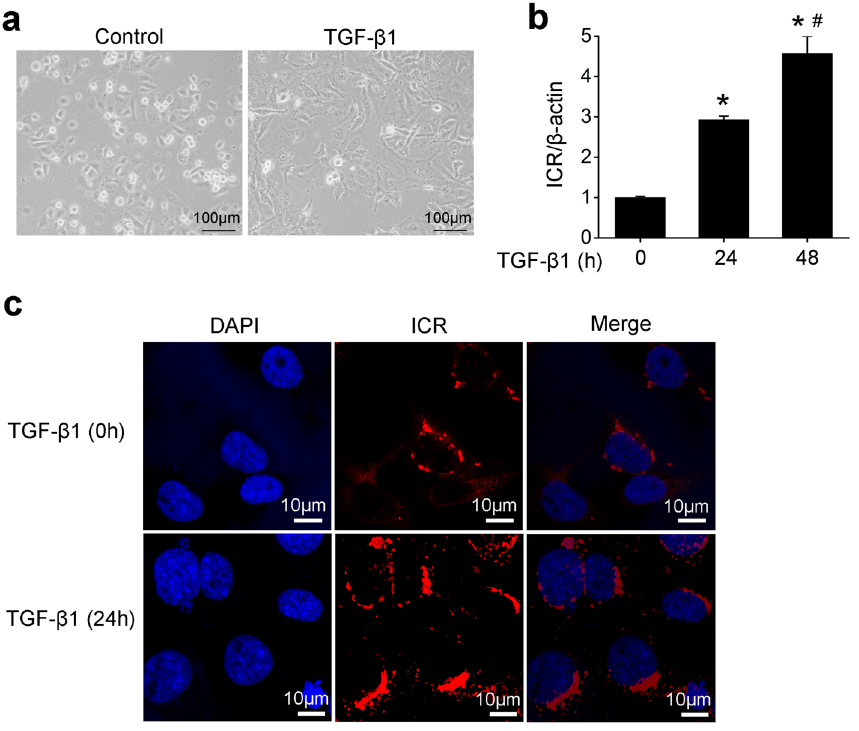
Figure 3. ICR was upregulated in human proximal tubular HK-2 cells cultured with TGF-β1. ( a ) The cell morphology of HK-2 cells treated with or without TGF-β1 (10 ng/ml) for 48 h. ( b ) QPCR analysis after normalization against β-actin showed an increase in the level of ICR in HK-2 cells treated with TGF-β1(10 ng/ ml, 24 h and 48 h) compared to the cells without treatment. ( c ) Representative confocal fluorescence in situ hybridization images showed that ICR was mainly distributed in cytoplasm of HK-2 cells treated with or without TGF-β1 (10 ng/ml) for 24 h. Data are presented as means ± SD of three independent experiments. * P (vs. TGF-β1 0 h) < 0.05, # P (vs. TGF-β1 24 h) <